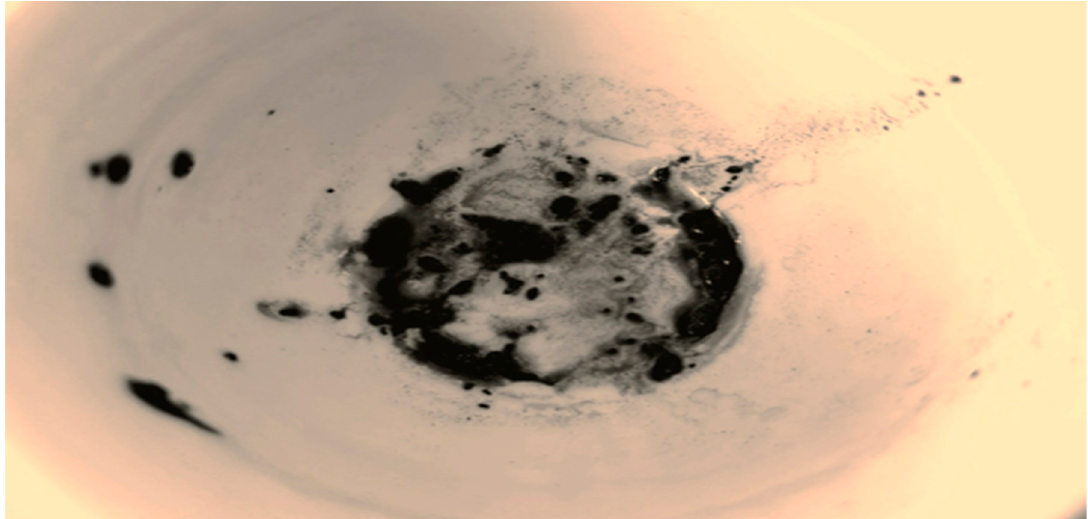
Figure 4. Energy dispersal in the Crab Nebula: An artist’s interpretation.